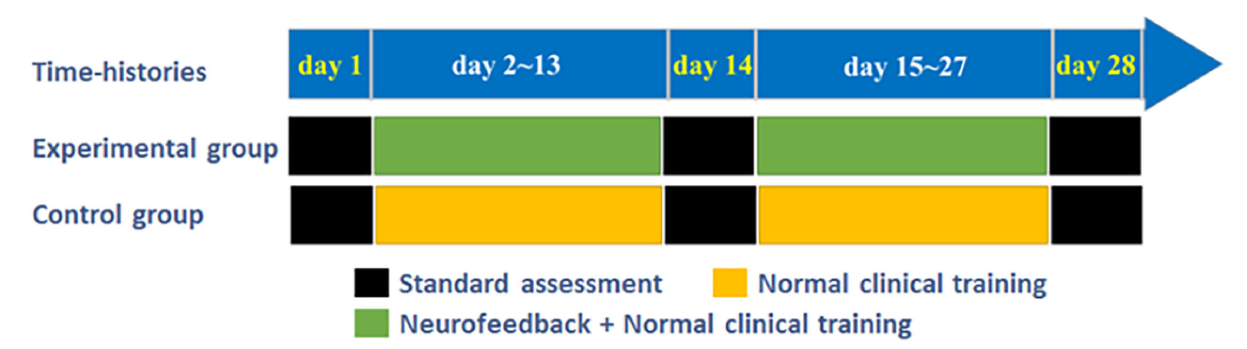
FIGURE 1 | Schematic diagram of long term NFT experiment and control experiment